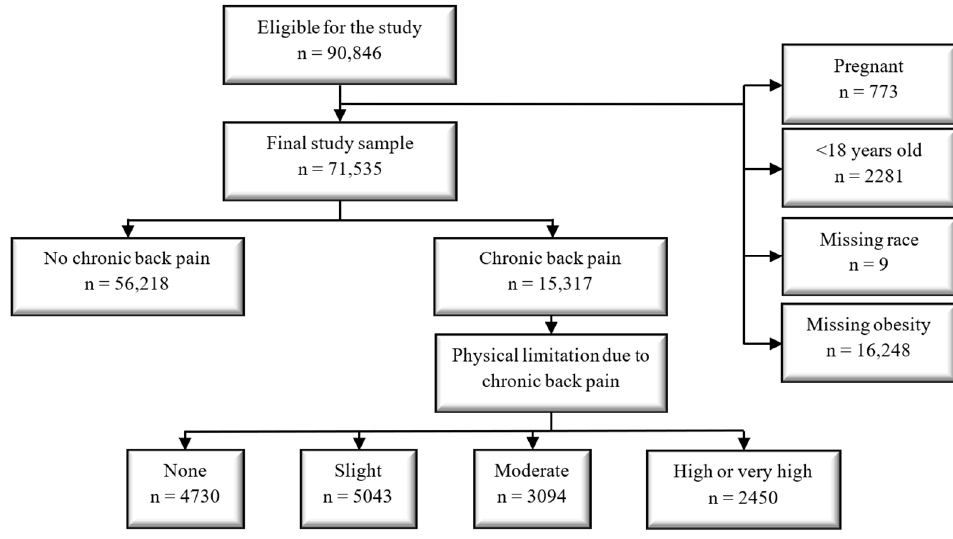
Figure 1. Final study sample cohort diagram.